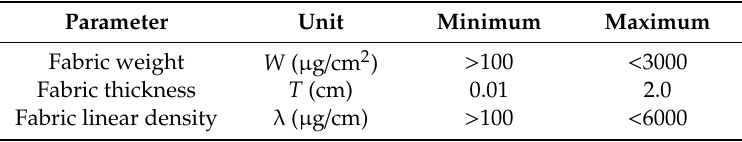
Table 1. The possible ranges of fabric parameters *.